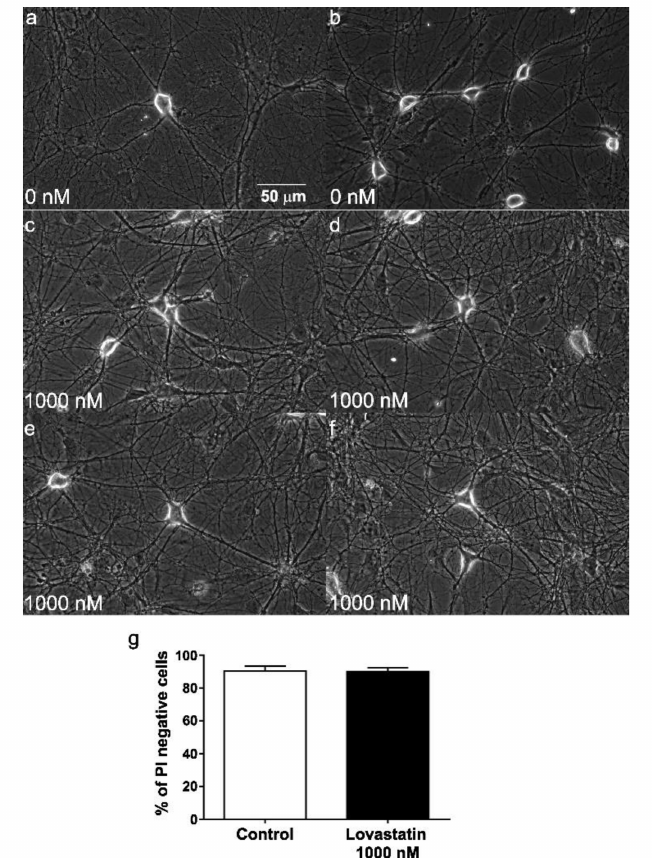
Figure 2. Two independent assays to assess neuronal cell viability of lovastatin treatment. ( a ) In the example shown, cultured hippocampal neurons were treated ( c – f ) with the maximal concentration (1000 nM) of lovastatin or with vehicle in the culture medium ( a , b ) for a total of 14 days. Wide-field images of typical cultures. ( g ) In the parallel fluorescence assay, neurons were stained with the probe propidium iodide (PI) and imaged. The percentage of PI-negative cells was counted and used for comparison with vehicle-treated control